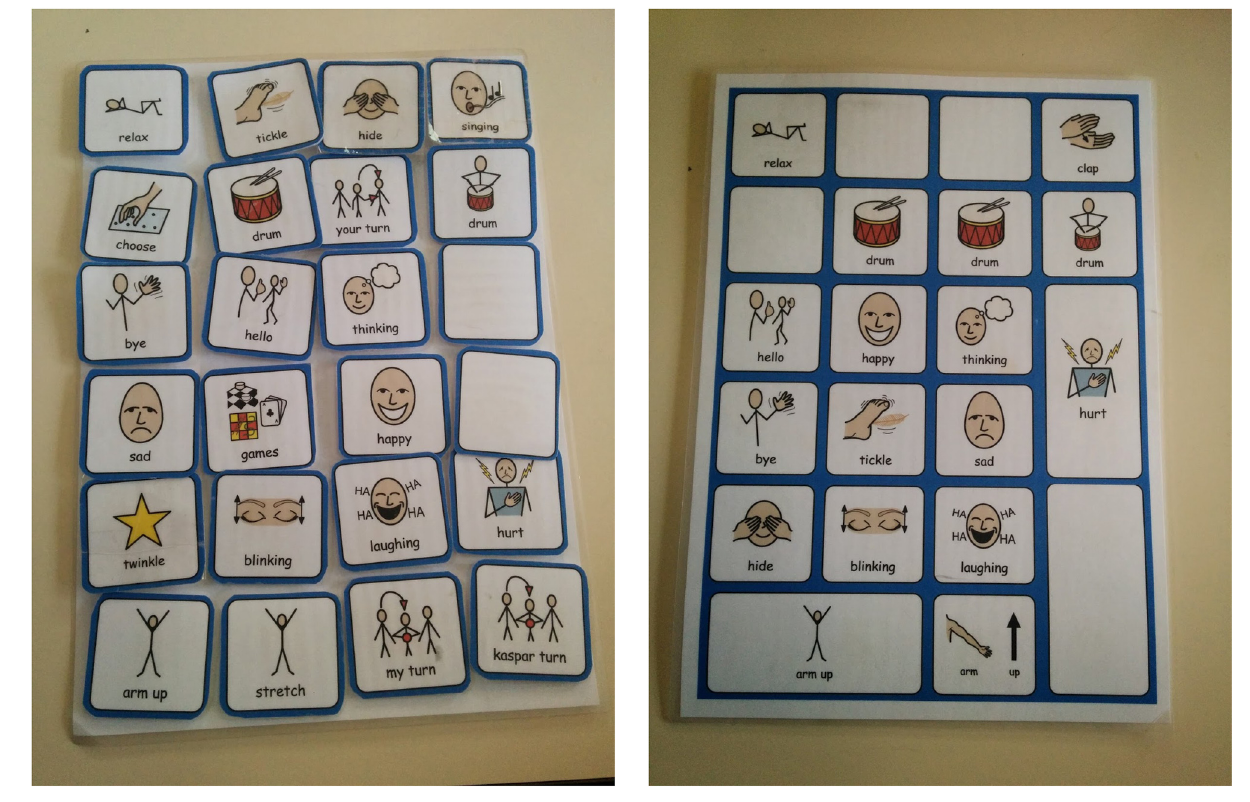
Figure 8: Sample PECS card set. Figure 9: Reproduction of control keypad using the PECS